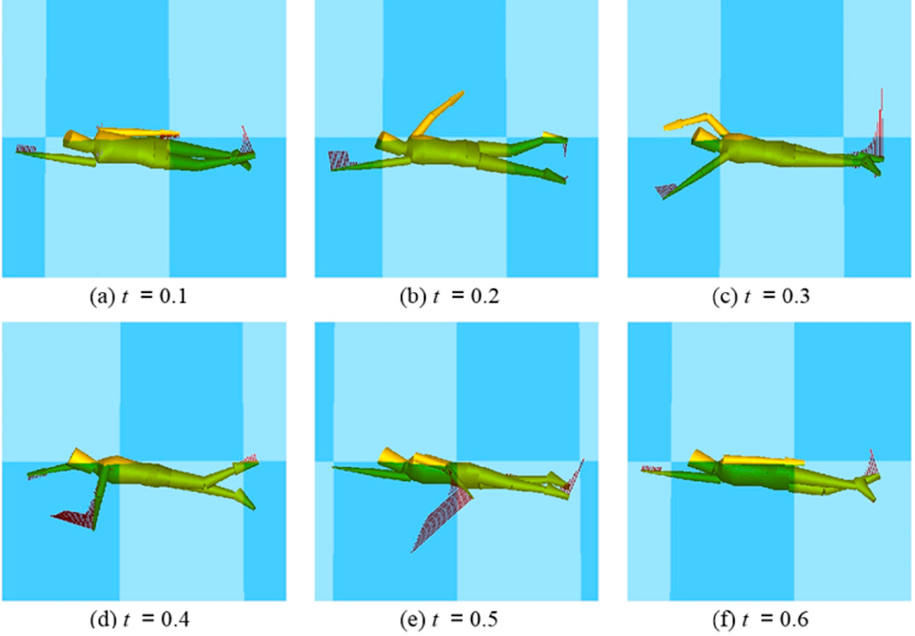
Figure 2. Swimming dynamics modeling and dynamic process simulation proposed by Nakashima et al. [5].